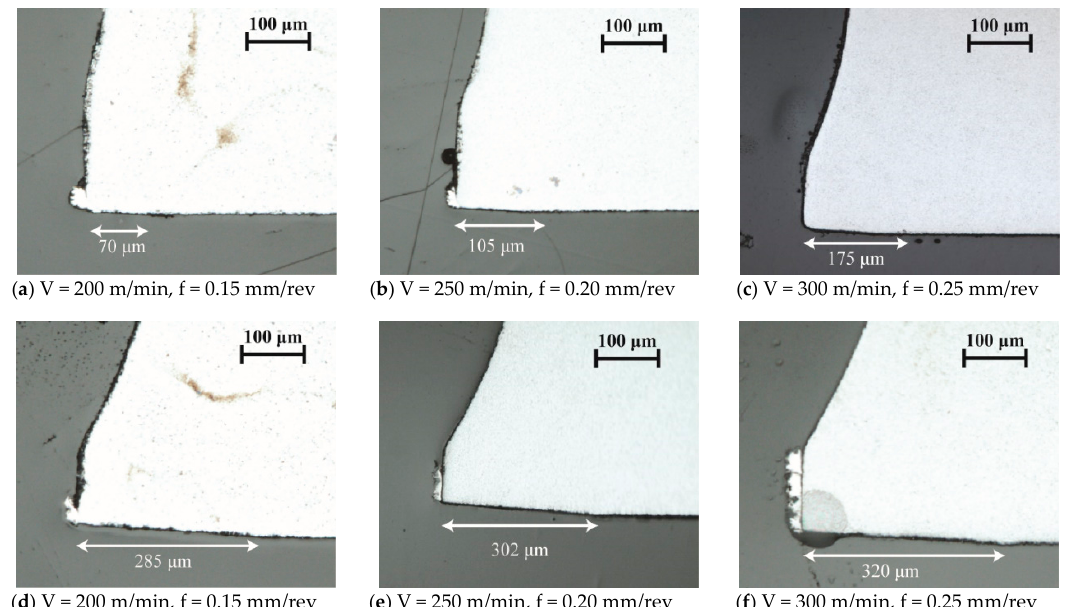
Figure 5. Geometry of worn edges after machining first ( a – c ) and last ( d – f ) fin with the lowest, mid-